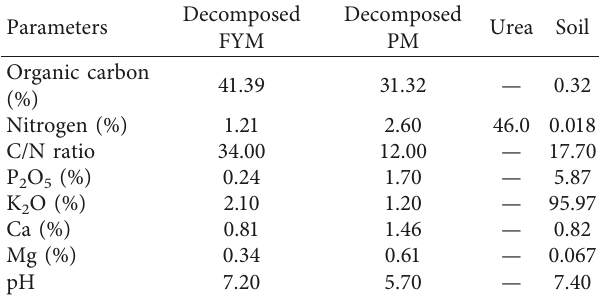
Table 1: Physical and chemical properties of different organic and inorganic fertilizers and soil before planting strawberry